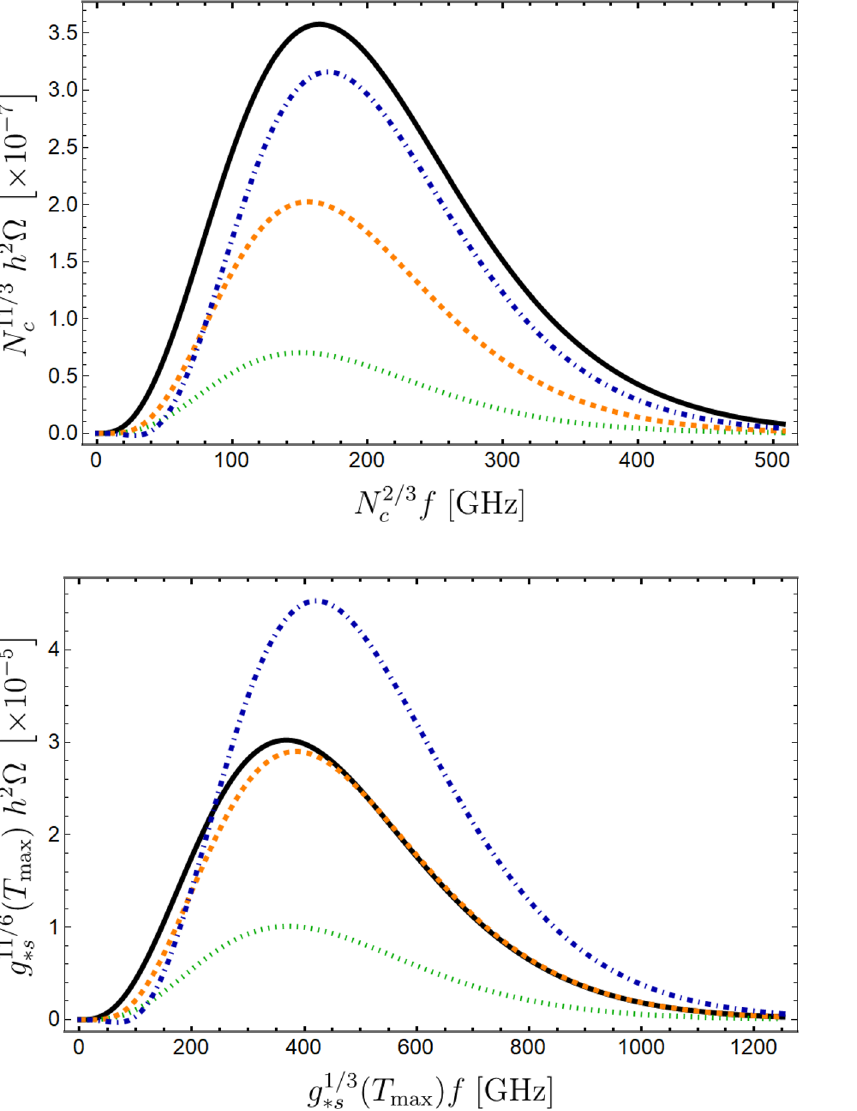
Figure 4 . Gravitational waves energy density as a function of the current frequency f after convolution with the expansion of the Universe, with ˜Ω ≡ M Pl (holographic) strong coupling calculation (solid black), λ = 0 . 1 (dotted green), λ = 0 . 5 (dashed orange) and λ = 1 . 8 (dot-dashed blue). The peak of the spectra occur around N 2 / 3 c f ∼ 150 GHz for different values of λ